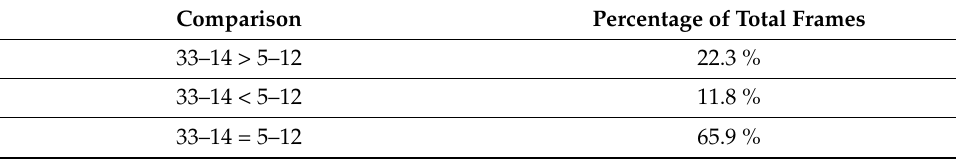
Figure 12. Classified per-frame target detection success rate—Comparison between scenarios. Table 1. Direct comparison between scenarios. The table indicates the percentage of frames for which each scenario outperformed the other in terms of correct detections, including the percentage of frames where performance was